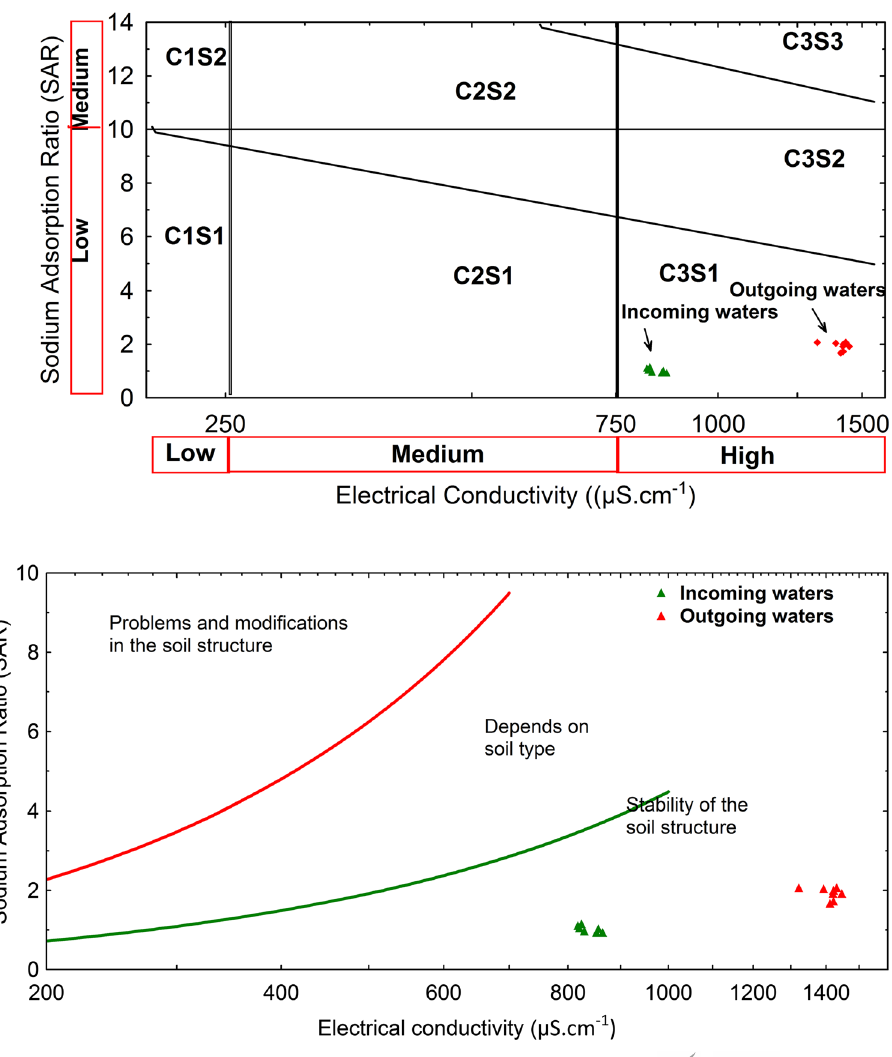
Fig. 6 Quality of the incoming (in green) and outgoing waters (in red) in relation to salinity and sodium waters in the phar- maceutical plant from February 27 to June 17, 2013